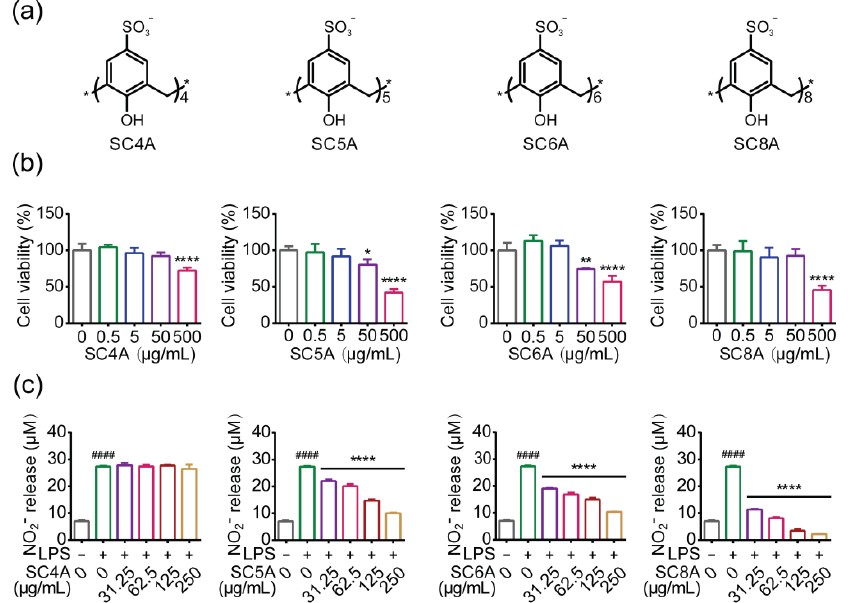
Figure 1. ( a ) Structure of SC4A, SC5A, SC6A, and SC8A; ( b ) viabilities of BV2 cells treated with SC4A, SC5A, SC6A, SC8A for 24h (* p < 0.05, ** p < 0.01, **** p < 0.0001); ( c ) measurement of NO generation by Griess assay. BV2 cells culture medium was added with LPS (0.1 µ g/mL) alone, LPS (0.1 µ g/mL) with SC4A, SC5A, SC6A, SC8A for 24h, respectively. Cells cultured without LPS (0.1 µ g/mL) and calixarenes served as the control group. #### p < 0.0001 vs. the control group; **** p < 0.0001 vs. the LPS group.